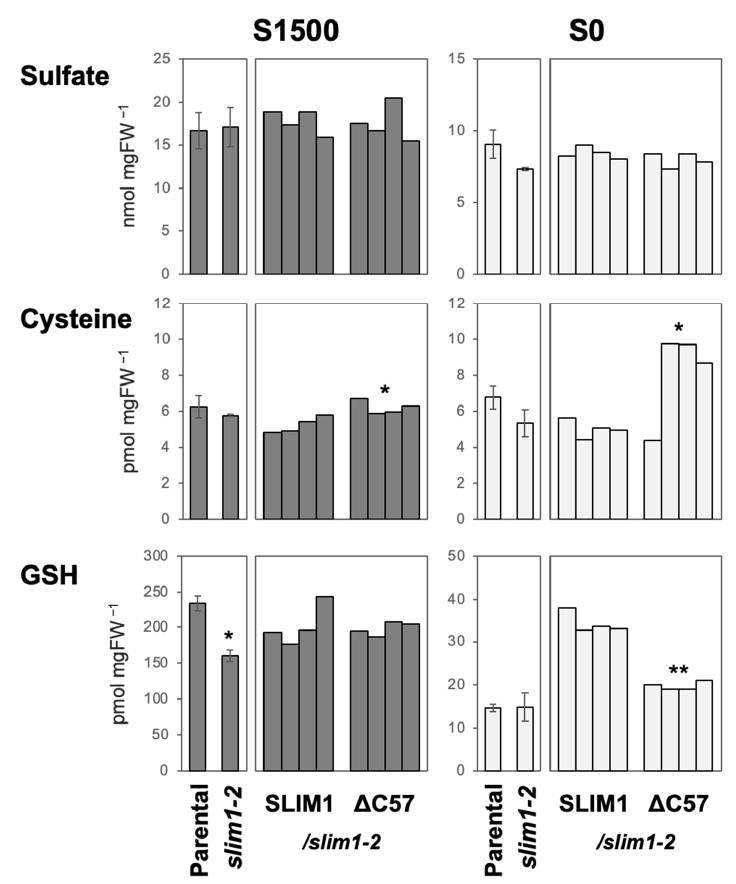
Figure 5. Sulfate, cysteine, and glutathione (GSH) levels in the complementation lines. Shoots of Parental ( P SULTR1;2 -GFP ), slim1-2 , and four independent lines of SLIM1/slim1-2 and Δ C57 /slim1-2 grown on S1500 and S0 media for 10 days were used for the metabolite analysis. The average values are indicated with error bars denoting SEM ( n = 3) for Parental and slim1-2 , and the single values are indicated for four independent transgenic lines generated for complementation with the full-length SLIM1 or Δ C57. Asterisks indicate significant differences between Parental and slim1-2 (left), and between SLIM1/slim1-2 and Δ C57 /slim1-2 (right) under S1500 and S0 conditions (Student’s t - test; ** p < 0.01, * 0.01 ≤ p < 0.05).